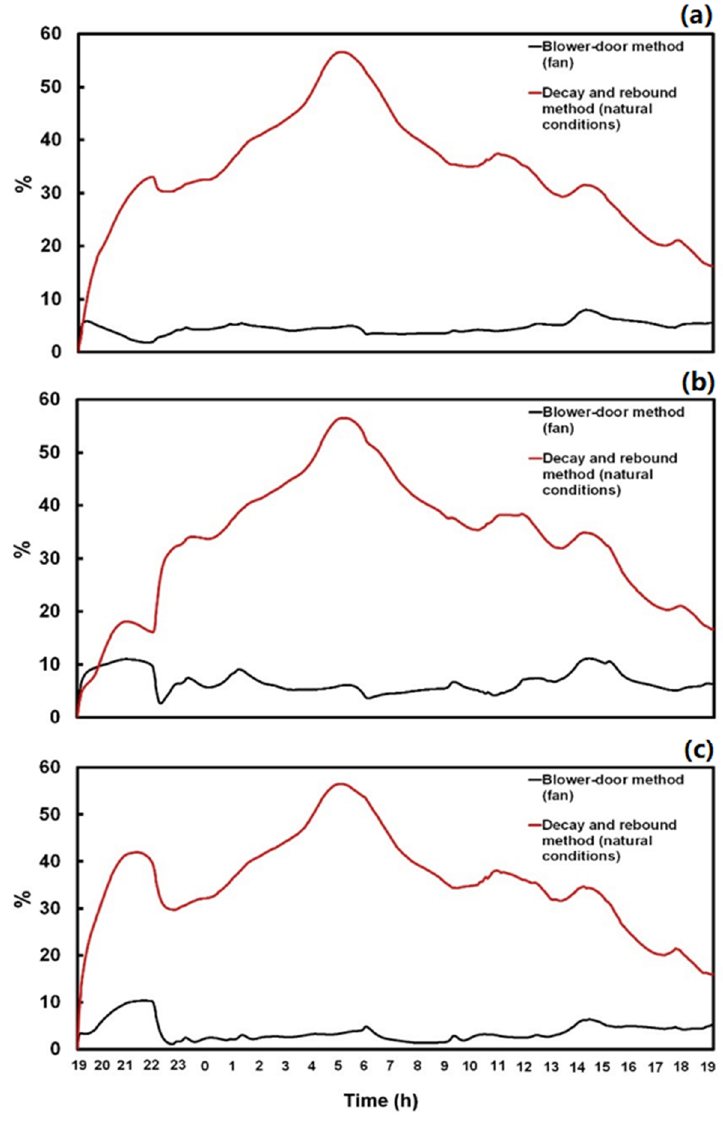
Figure 6. Coefficient of variation (%) of indoor PM 2.5 concentration in the living room ( a ), bedroom 1 ( b ) and bedroom 2 ( c ) under two conditions (−4 Pa pressure difference induced by fan and natural conditions) across four days in different seasons.